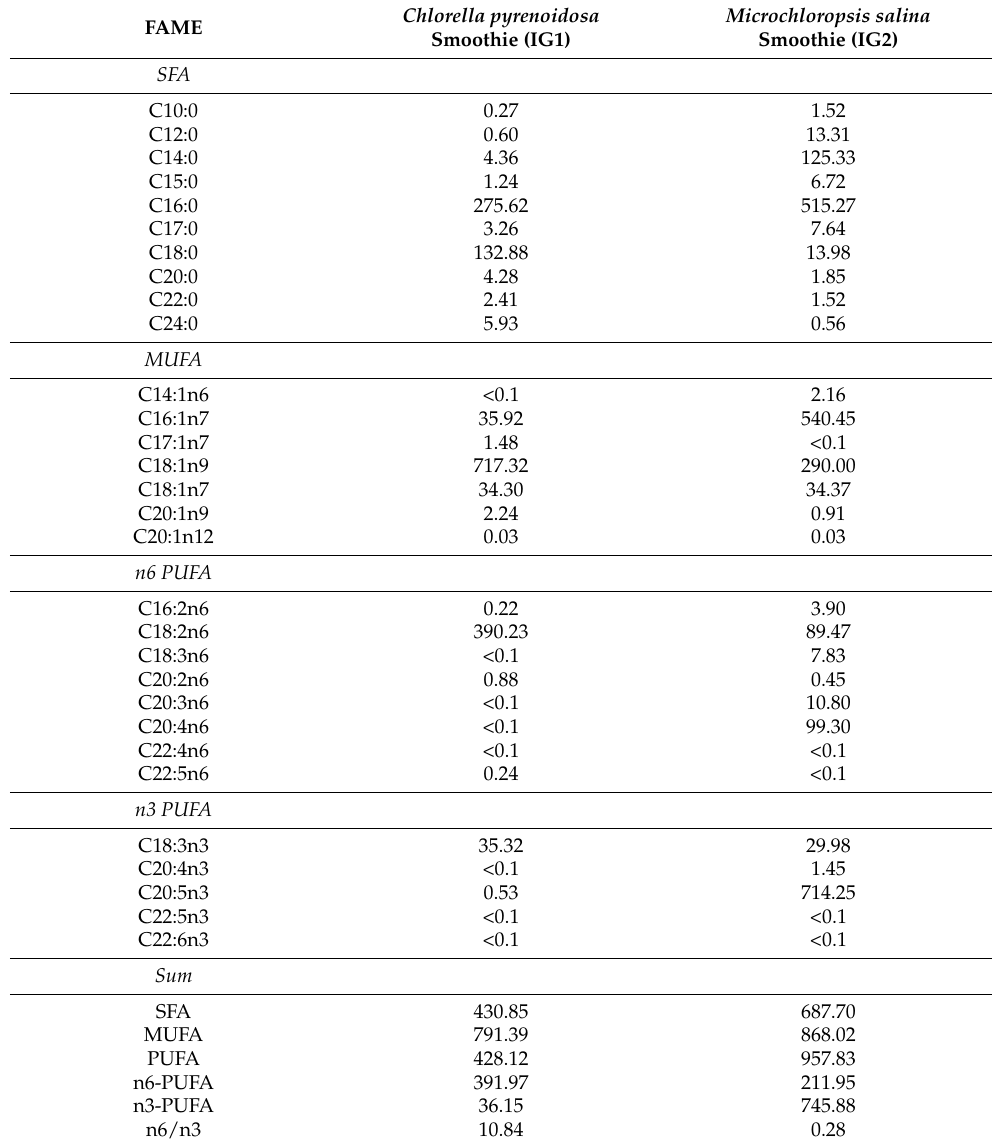
Table 2. Fatty acid profile of both intervention products (in mg/350 mL smoothie per